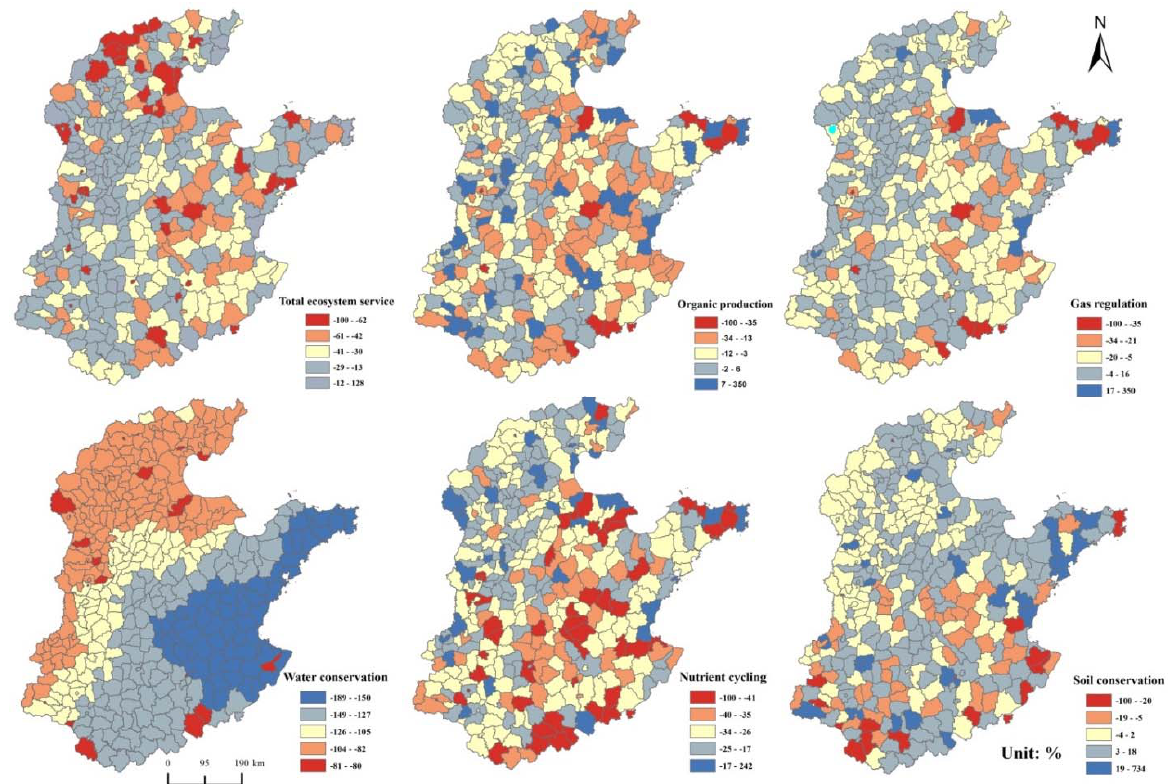
Figure 5. Percentage change in ESV induced by land use change in the